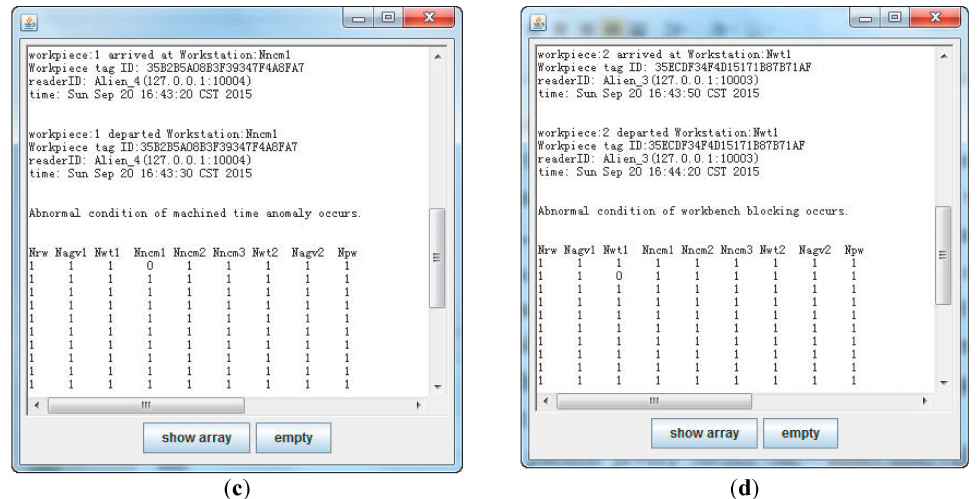
Figure 8. ( a ) Simulation result on workstation N rw ; ( b ) Simulation result on workstation N pw ; ( c ) Simulation result on workstation N ncm 1 ; ( d ) Simulation result on workstation N wt 1 .